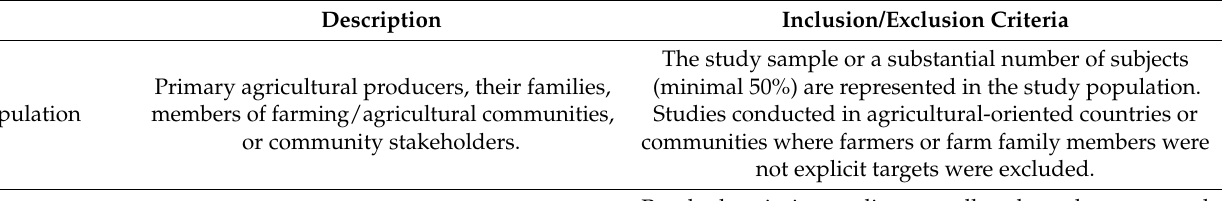
Table A1. Population-Intervention-Comparison-Outcome-Study Design